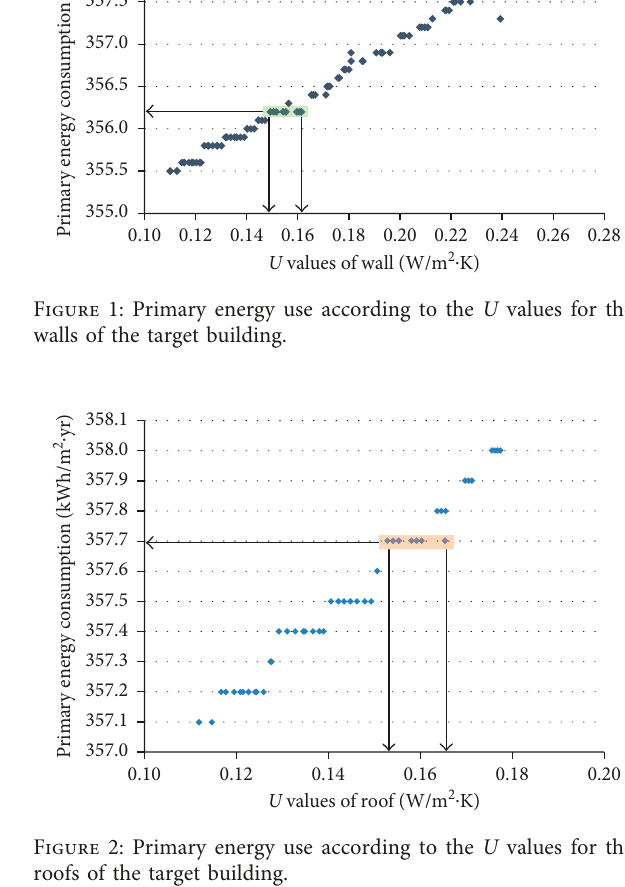
Figure 2: Primary energy use according to the U values for the roofs of the target